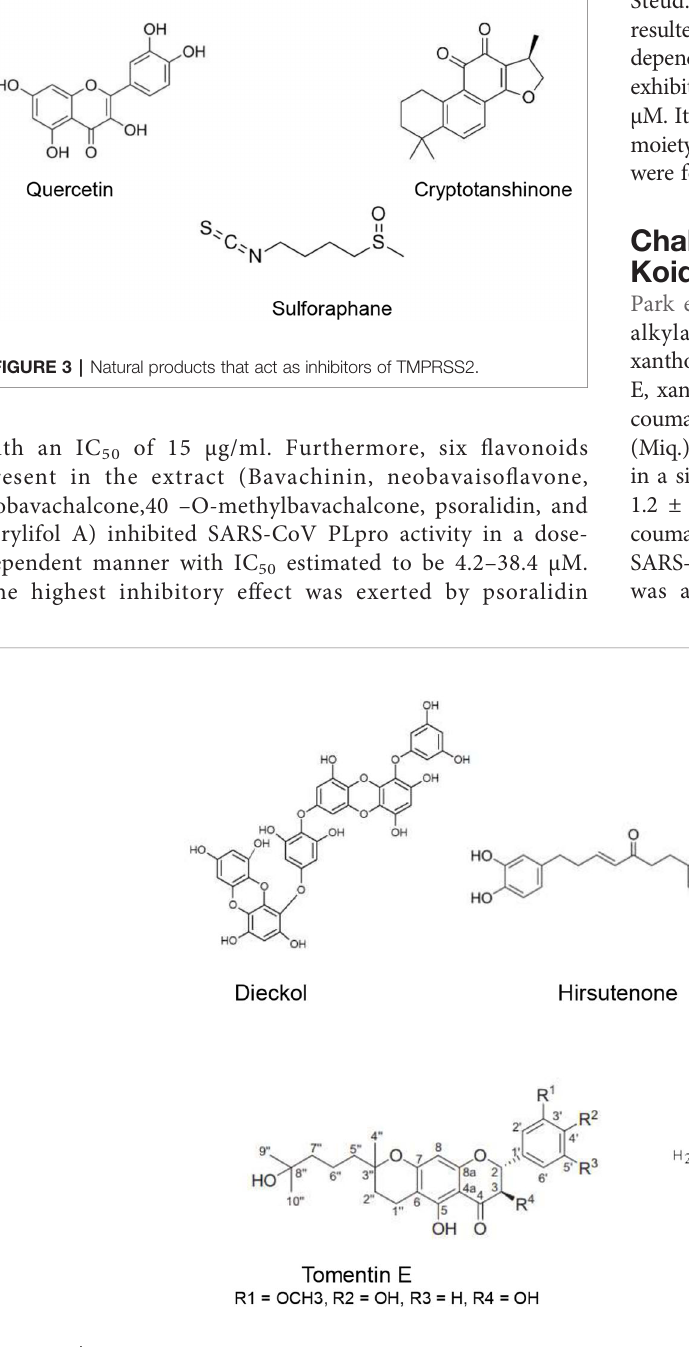
FIGURE 4 | Natural products that act as inhibitors of